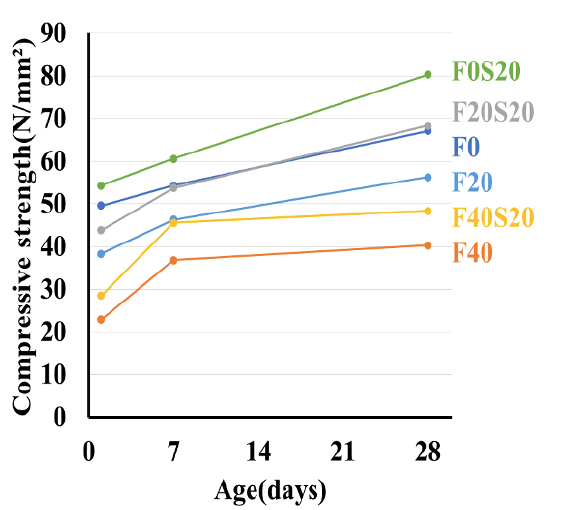
Figure 2. Compressive strength of mortar under 20 ◦ C-sealed